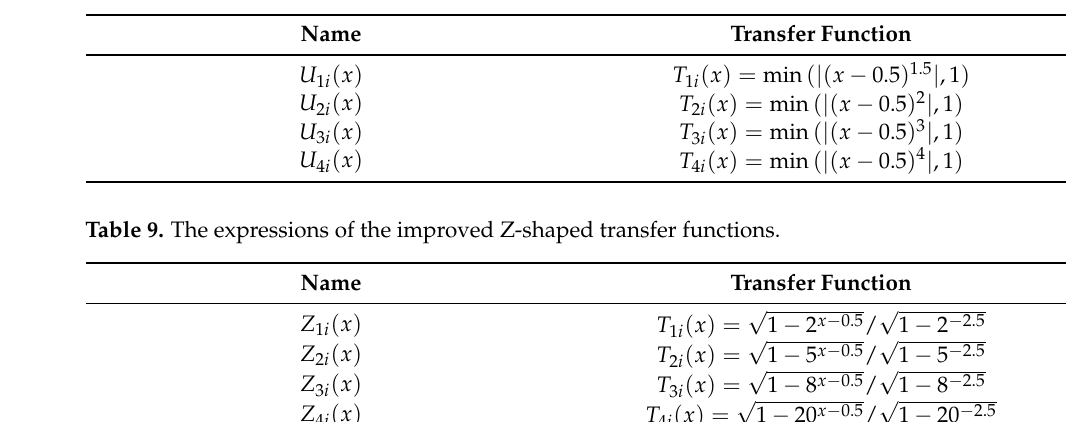
Table 8. The expressions of the improved U-shaped transfer functions.